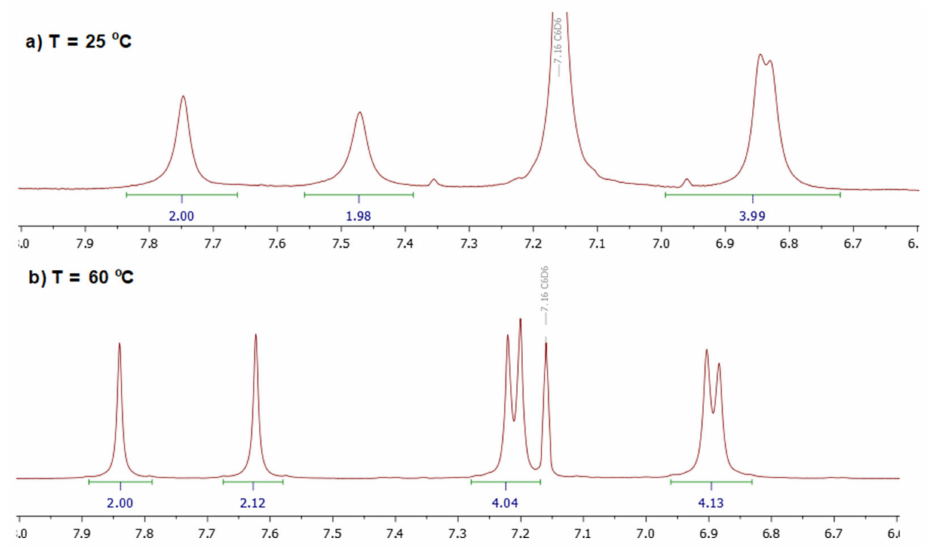
Figure 3. Fragments of 1 H NMR spectra of substance 4c in C 6 D 6 at ( a ) 25 ◦ C and ( b ) 60 ◦ C.